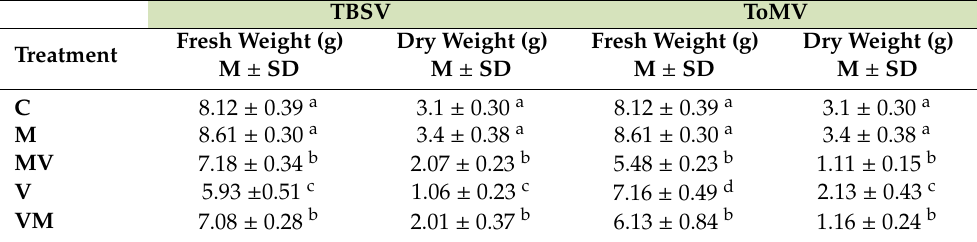
Table 3. Level of fresh weight (g) and dry weight (g) in the plants infected with TBSV and ToMV. Note. M ± SD = Mean ± Std. Deviation. Uninfected control plants without AM fungi (C), uninfected control plants with AM fungi (M) TBSV / ToMV-infected plants without AM fungi (V), TBSV / ToMV -infected plants before mycorrhiza (VM) inoculation and inoculated plants with mycorrhiza before TBSV / ToMV infection (MV). Values of each column followed by di ff erent letters indicate significant di ff erence between the level of FW and DW treatments according to ANOVA-Bonferroni post hoc-test ( p < 0.05). Values of each column followed by the same letters are not significantly di ff erent between the level of FW and DW treatments according to ANOVA-Bonferroni post hoc-test ( p < 0.05). Each value represents the mean of three replicates ±